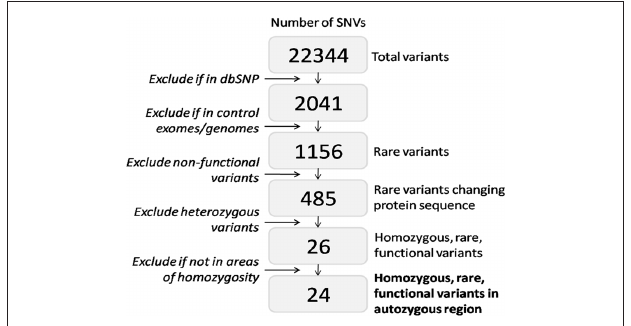
FiguRE 2 | Data analysis algorithm for whole exome sequencing data and location of pathogenic WRN mutation. Data analysis algorithm used for filtering all single nucleotide variants (SNVs) identified using exome-wide sequencing, with numbers of variants left at each filtering